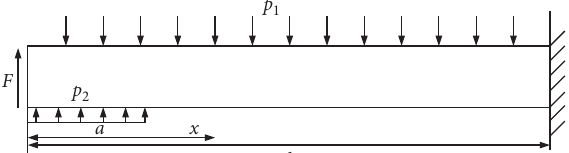
Figure 9: The mechanics model of reverse direction fault (the initial